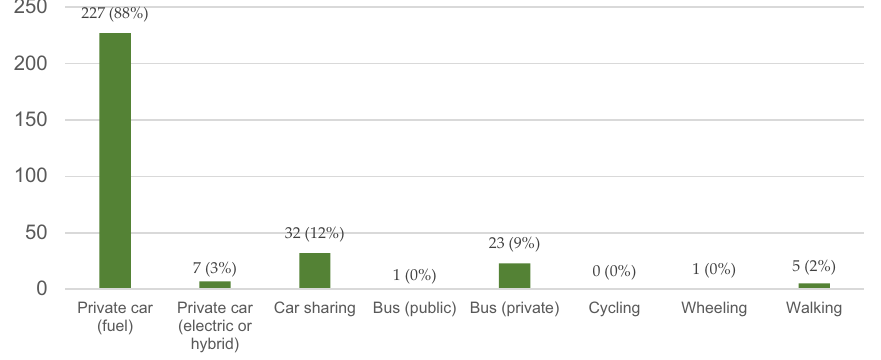
Figure 6. Principal mean/s of transportation to the campus.